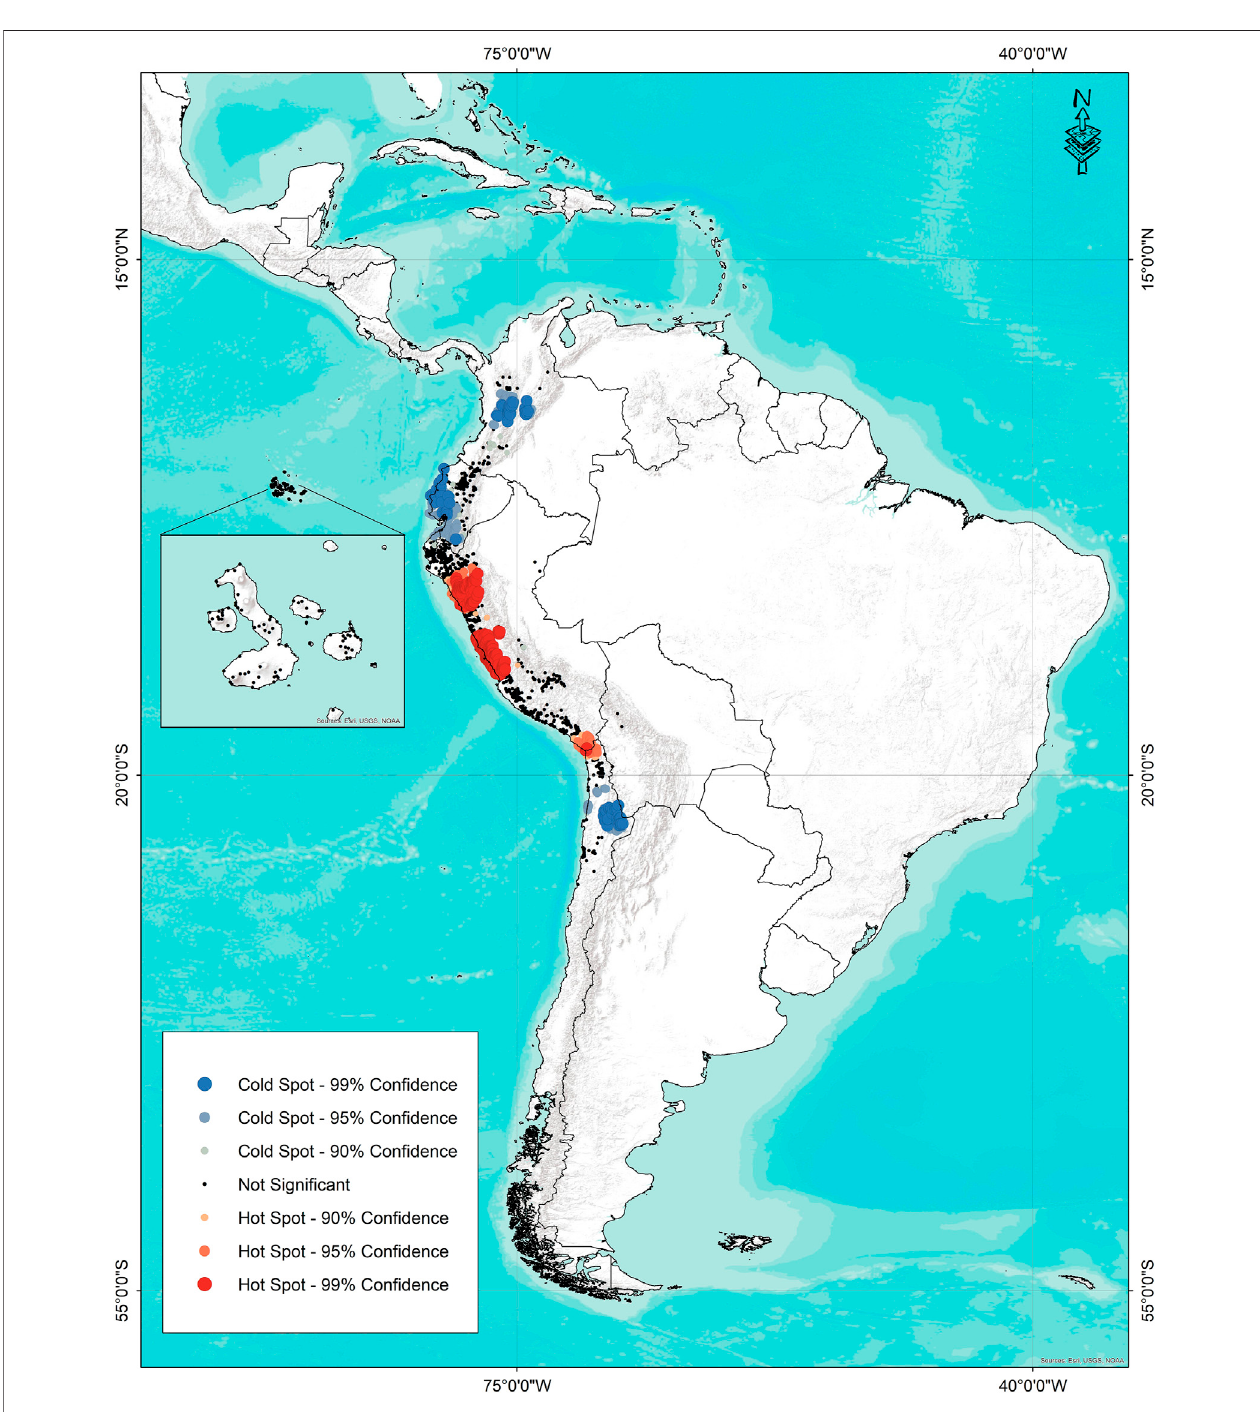
FIGURE 8 | Species diversity map hot spots (red) and cold spots (blue) for 12 wild tomato ( Solanum Sect. Lycopersicon) and 4 closely related species ( Solanum sect. Juglandifolia and sect. Lycopersicoides).